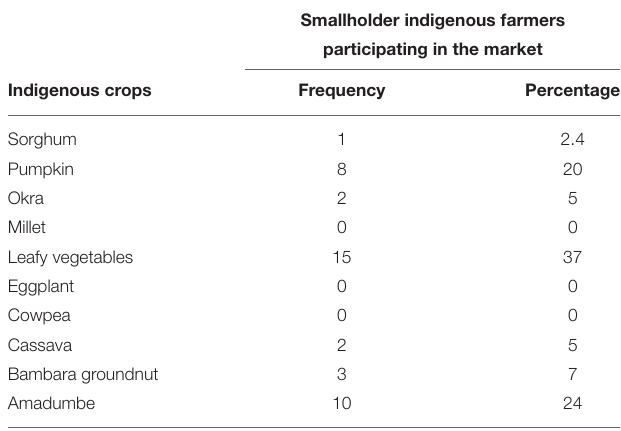
TABLE 3 | Distribution of all the indigenous crops grown by smallholder farmers. Indigenous crop farmers in the Mpumalanga